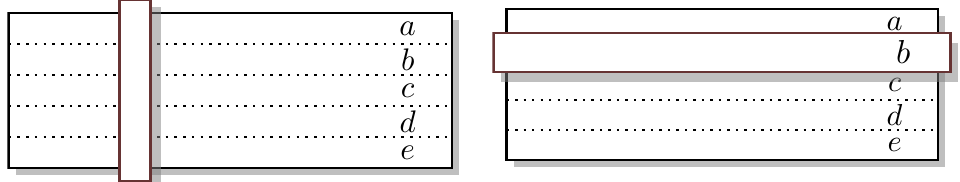
Figure 6: Data encryption and authentication with Ascon